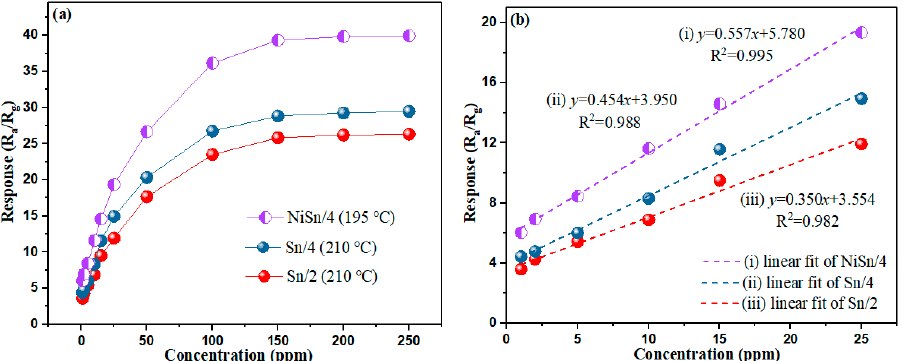
Figure 7. ( a ) Gas response of Sn/2, Sn/4 and NiSn/4 sensors to H 2 with various concentrations at their optimal operation temperatures, respectively; ( b ) the linear fitting curves of the sensor devices at low H 2 concentrations (1–25 ppm).